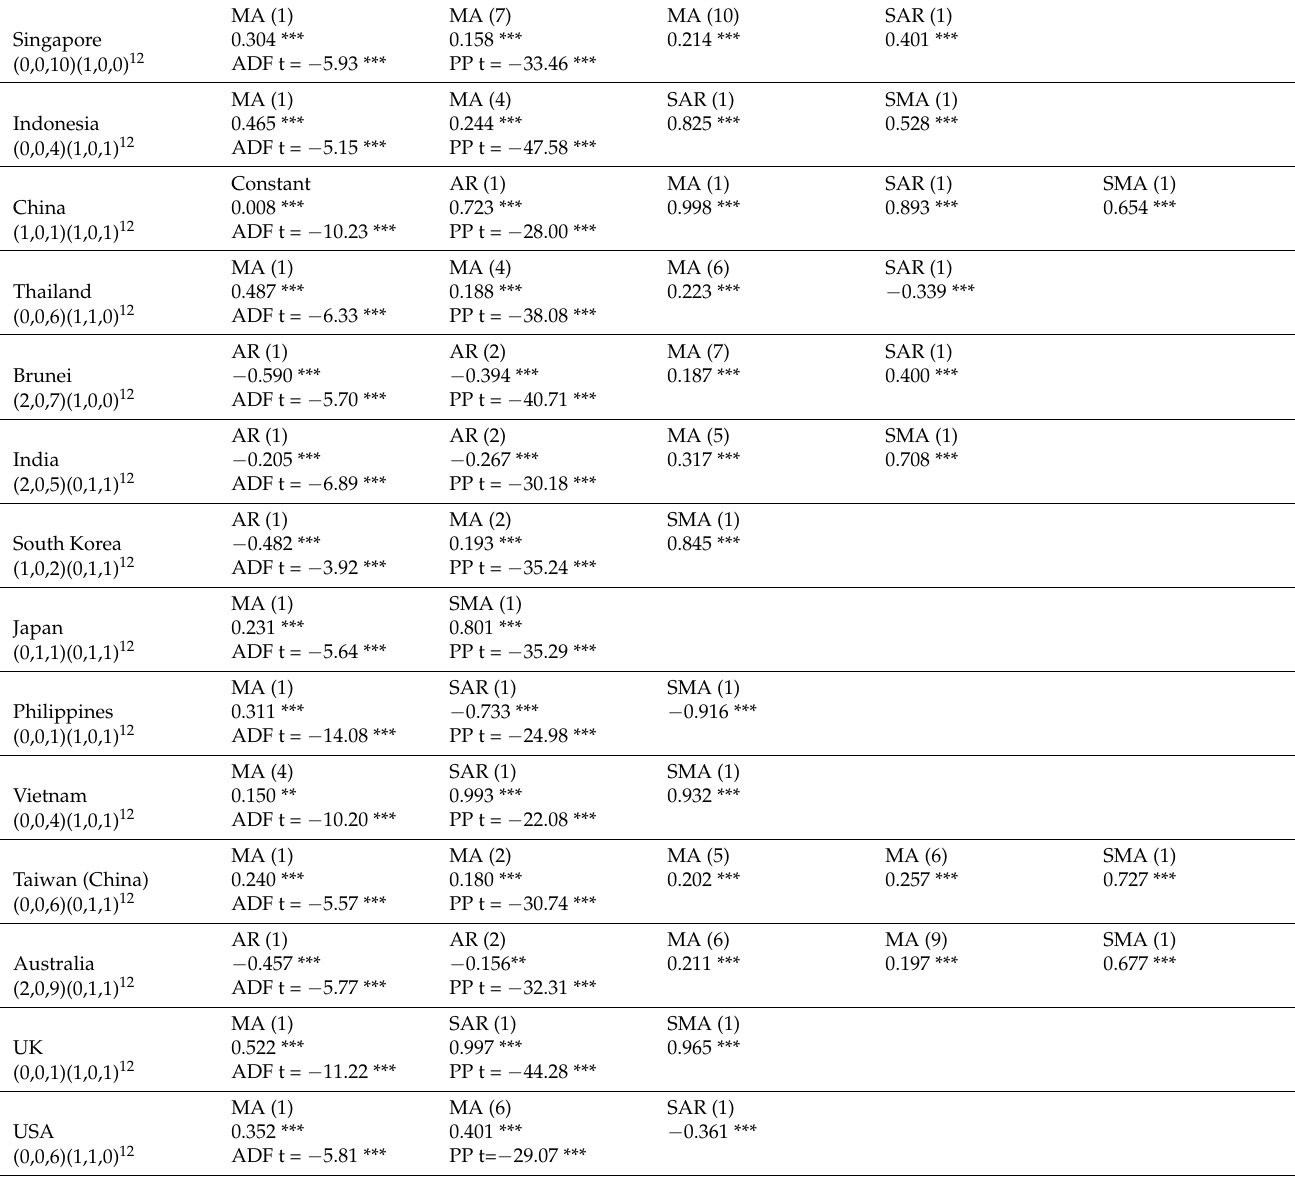
Table 4. Mean equation